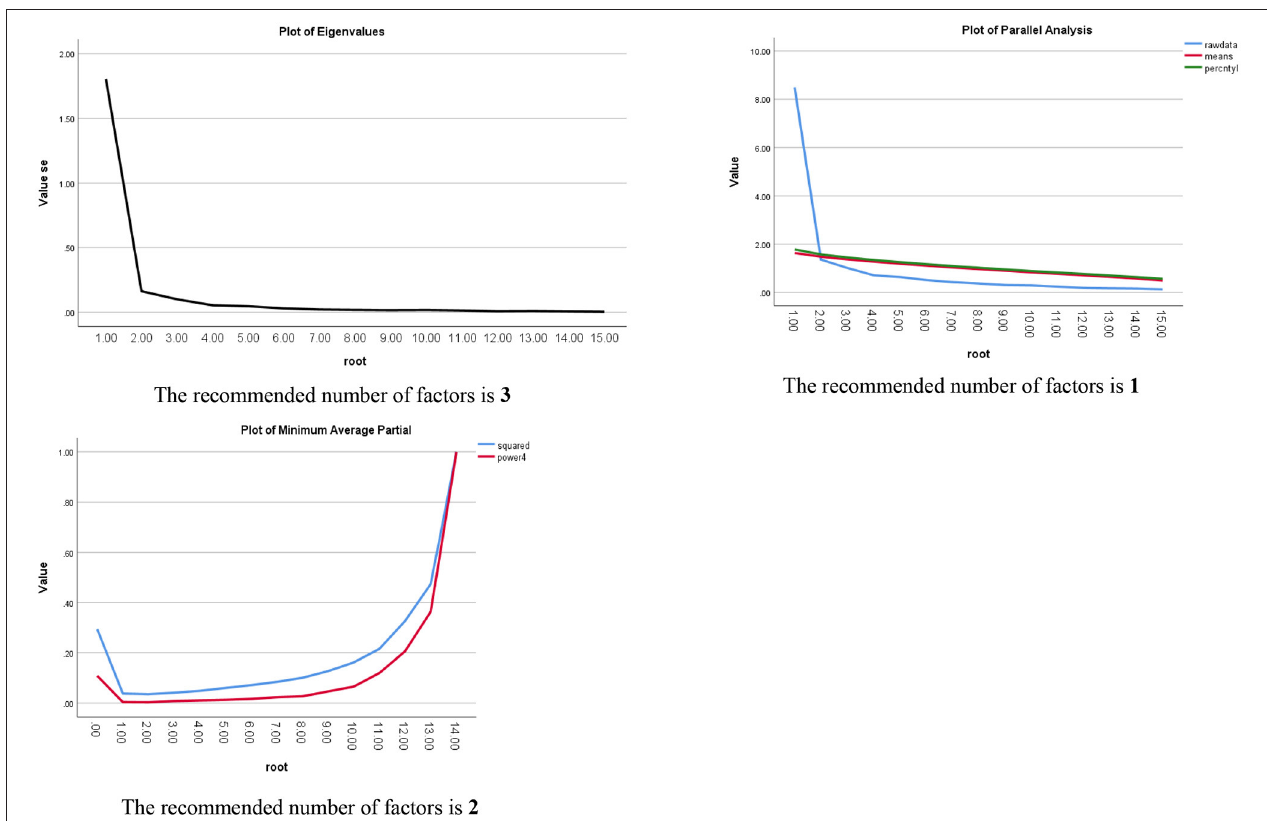
FIGURE 1 | Plots of three methods to define factors